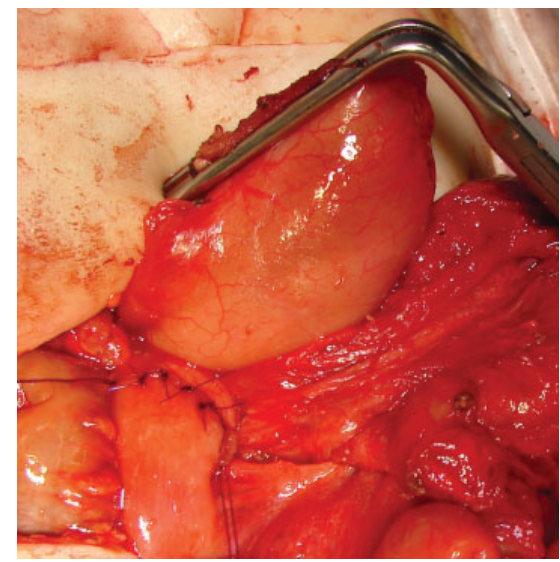
Fig. 3 Whipple operation with